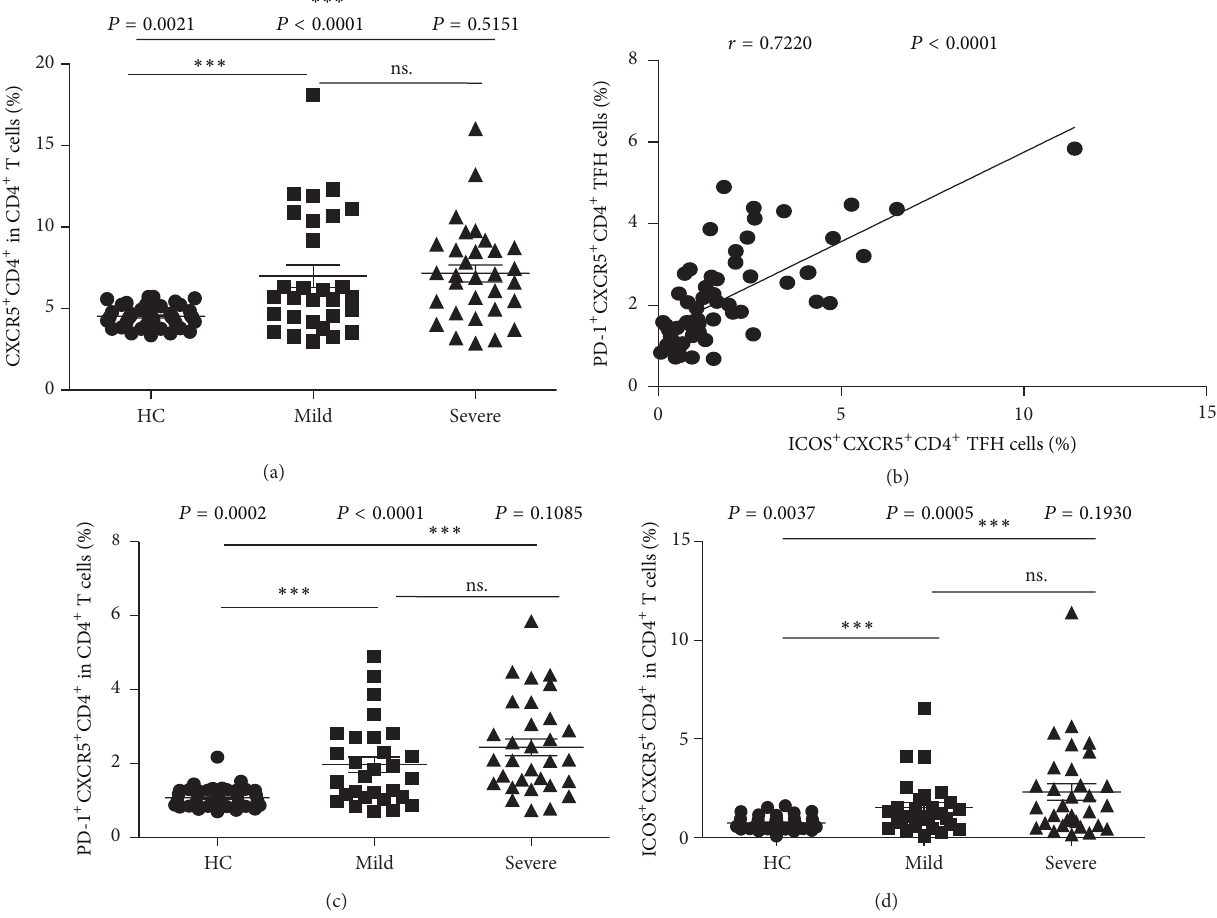
Figure 2: Increased percentages of circulating CXCR5 + CD4 + TFH cells with ICOS high and PD- 1 high expression in peripheral blood of EV71- infected patients. The percentages of CXCR5 + CD4 + TFH cells in the total CD4 + T cells (a); the correlation between the percentages of PD- 1 + CXCR5 + CD4 + TFH cells and ICOS + CXCR5 + CD4 + TFH cells from EV71-infected patients ( 𝑛 = 60 ) (b); PD-1 + CXCR5 + CD4 + TFH cells (c) and ICOS + CXCR5 + CD4 + TFH cells (d). Data shown were the mean ± SD (standard deviation, SD). The horizontal lines show the median. ∗ 𝑃 <